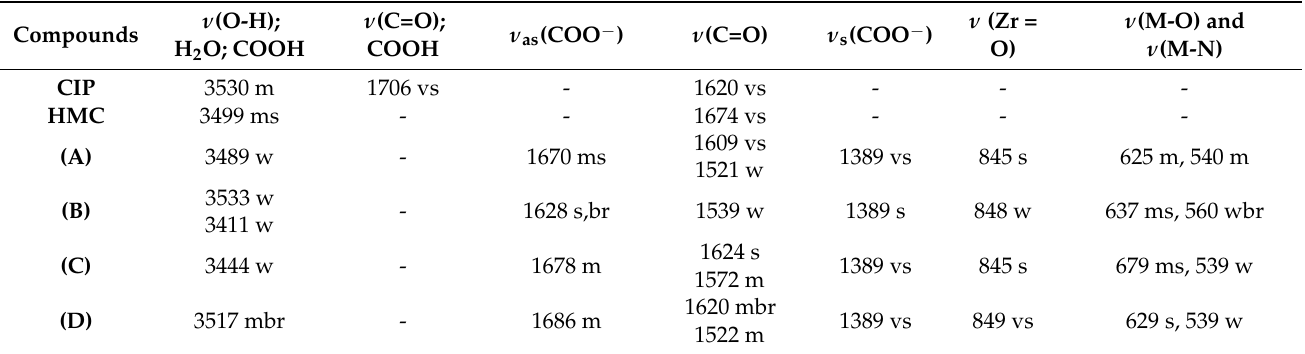
Table 2. Selected infrared absorption frequencies (cm − 1 ) for CIP, HMC, and their Zr(IV)